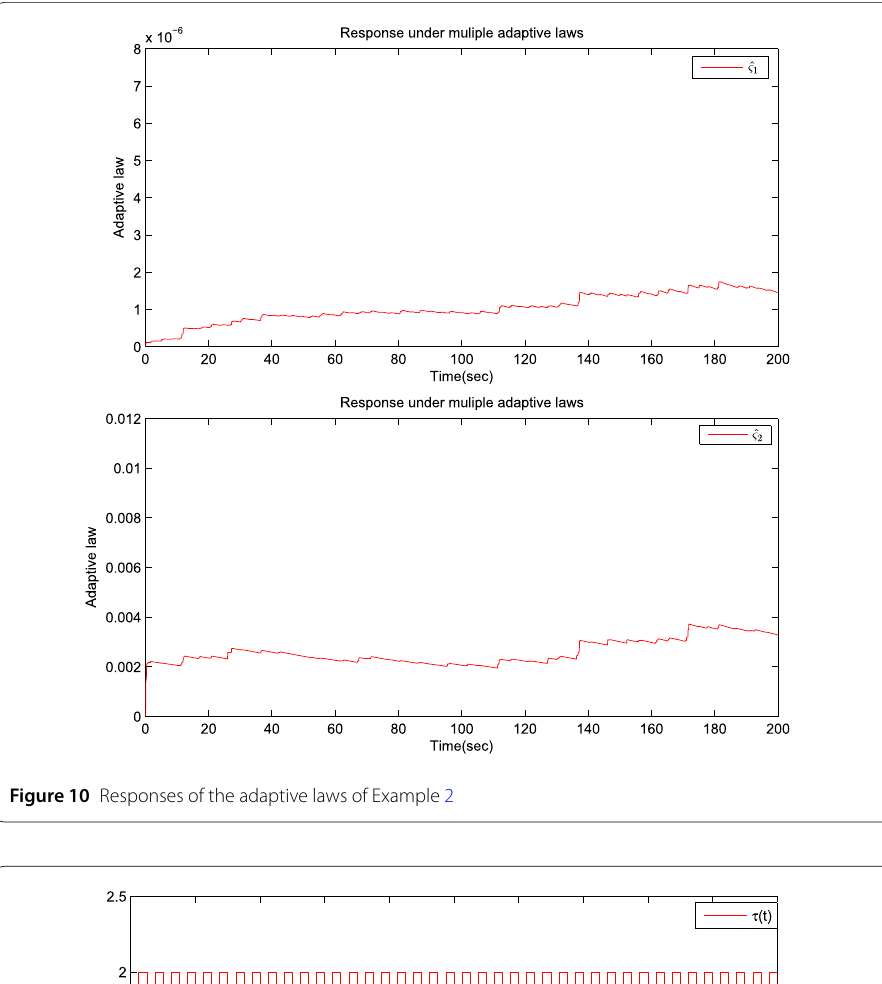
Figure 10 Responses of the adaptive laws of Example 2